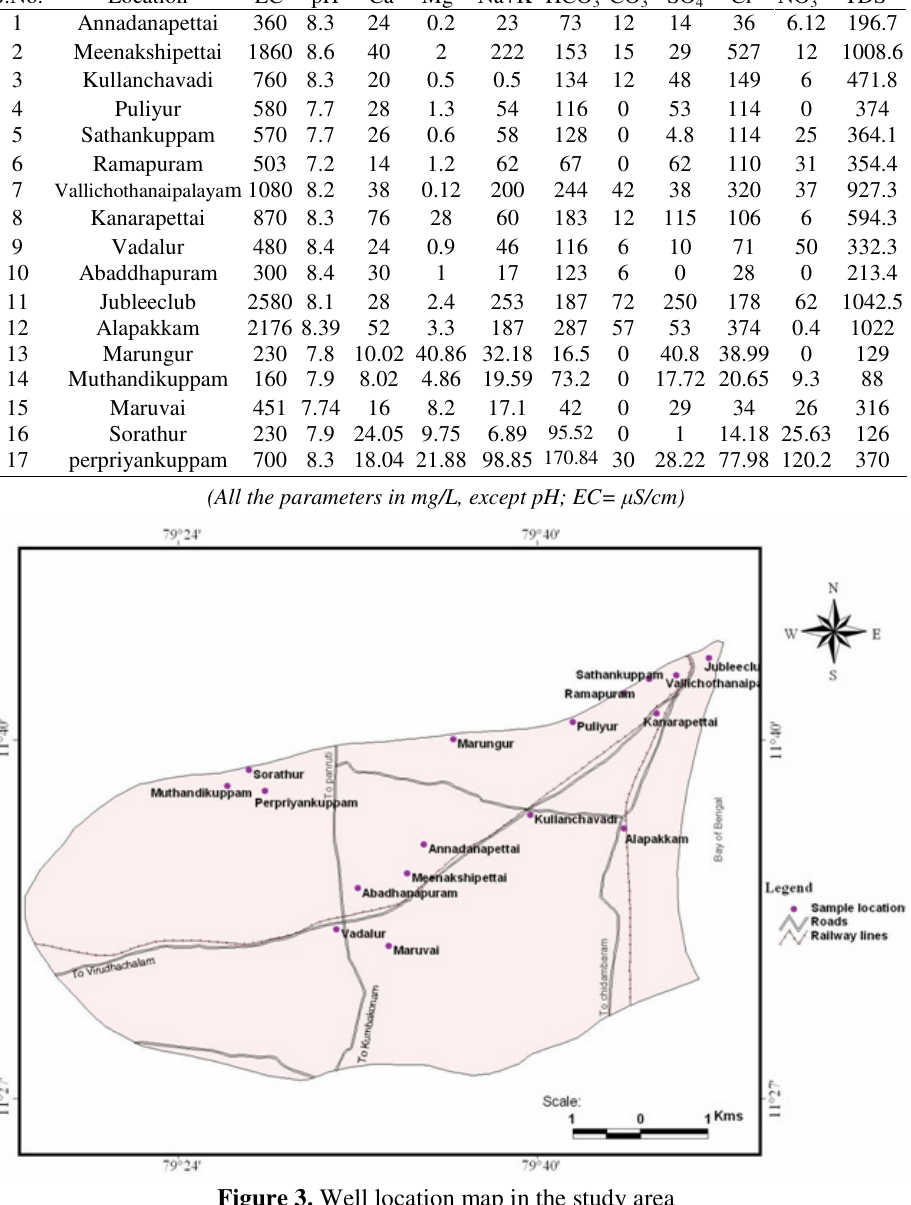
Figure 3. Well location map in the study